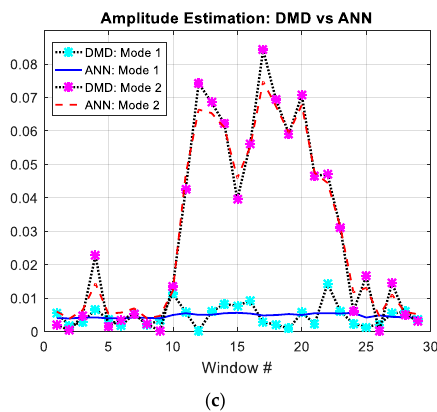
Figure 5. Comparison of the estimates produced by dynamic mode decomposition (DMD) versus the estimates produced by the ANN approach for the case of Dataset DS1: ( a ) frequency; ( b ) damping, ( c ) amplitude.